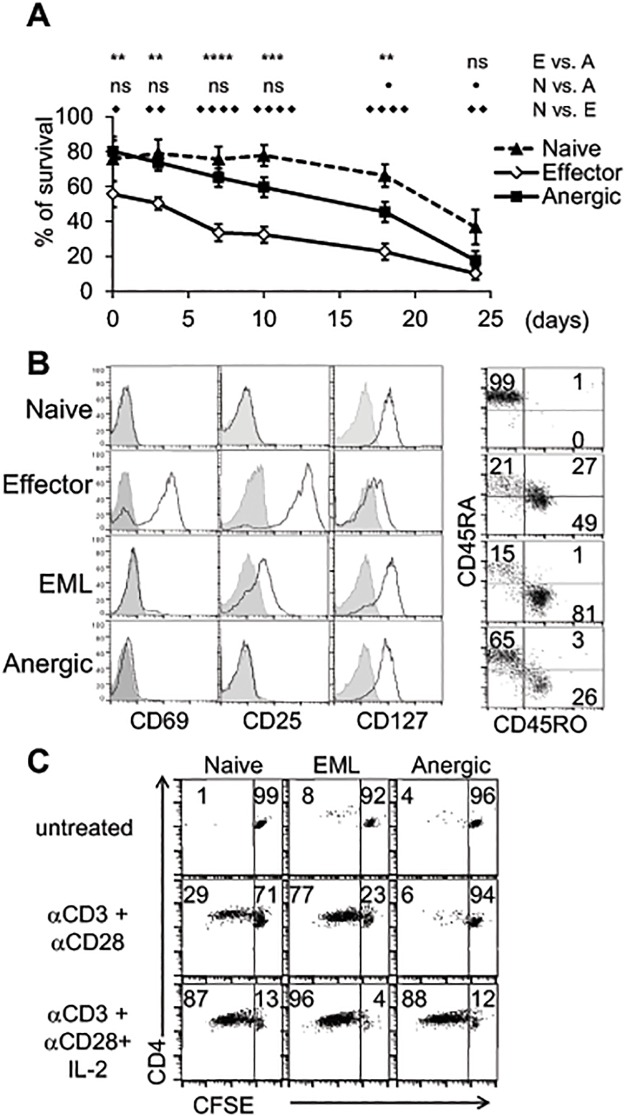
Survival, surface marker expression, and proliferation rate of anergic, effector/memory-like (EML), and naïve CD4+ T cells.Naïve, effector, and anergic cells were purified after 4 days of primary activation in the presence of autologous APCs. A. Cells were cultured in medium with 10% FBS and stained with Annexin V and 7-AAD to define apoptotic vs. live cells (n = 10). The data are presented as mean ± SEM. (**p<0.01, ***p<0.001, ****p<0.0001; ns, not significant). B. Fluorescence intensity of the indicated cell surface markers was measured on naïve, 4 days activated (effector), or 4 days activated and 3 days rested (EML and anergic) cells. The histograms show the expression of cell surface markers (solid line) and IgG control (gray plot). C. Purified populations of CD4+ T cells were rested for 4 days in medium, labeled with CFSE, and left untreated or re-stimulated with plate-bound αCD3 (5 μg/ml) + soluble αCD28 (2 μg/ml) ± IL-2 (100 U/ml). Numbers represent the percentage of dividing or non-dividing cells. B-C. Shown is one representative experiment from at least 3 experiments.